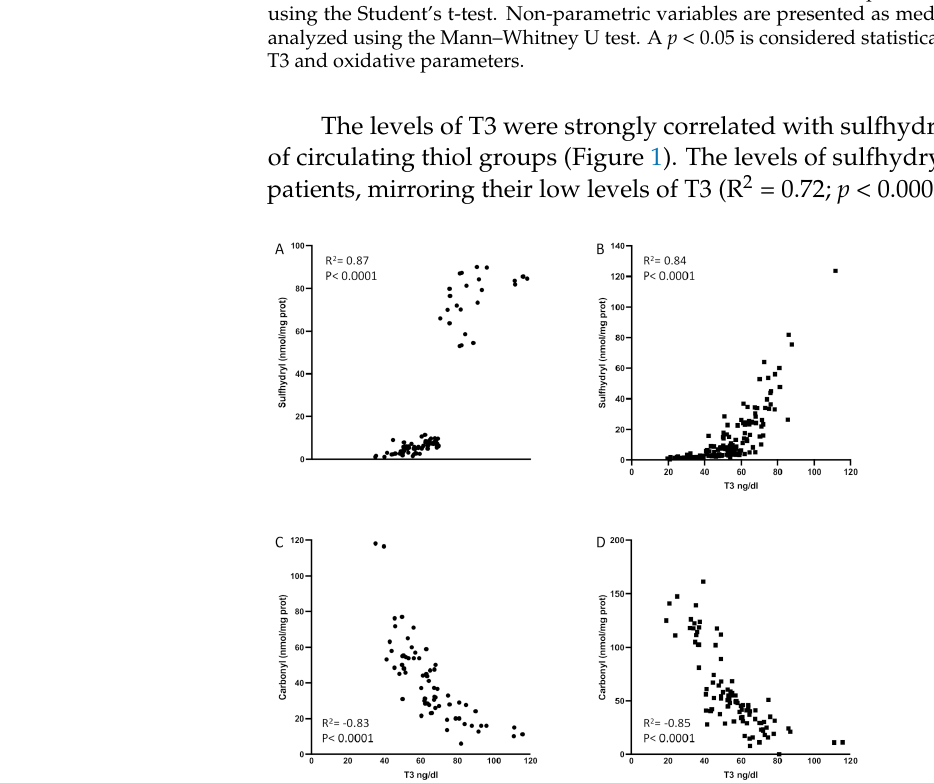
Figure 1. Sulfhydryl levels are correlated with serum T3 in patients with sepsis ( A ) and septic shock ( B ). Carbonyl levels are inversely correlated with T3 levels in patients with sepsis ( C ) and septic shock ( D ). No outliers were omitted in this analysis. The p -levels are denoted in the graphs. T3: triiodothyronine. Spearman test was used to perform